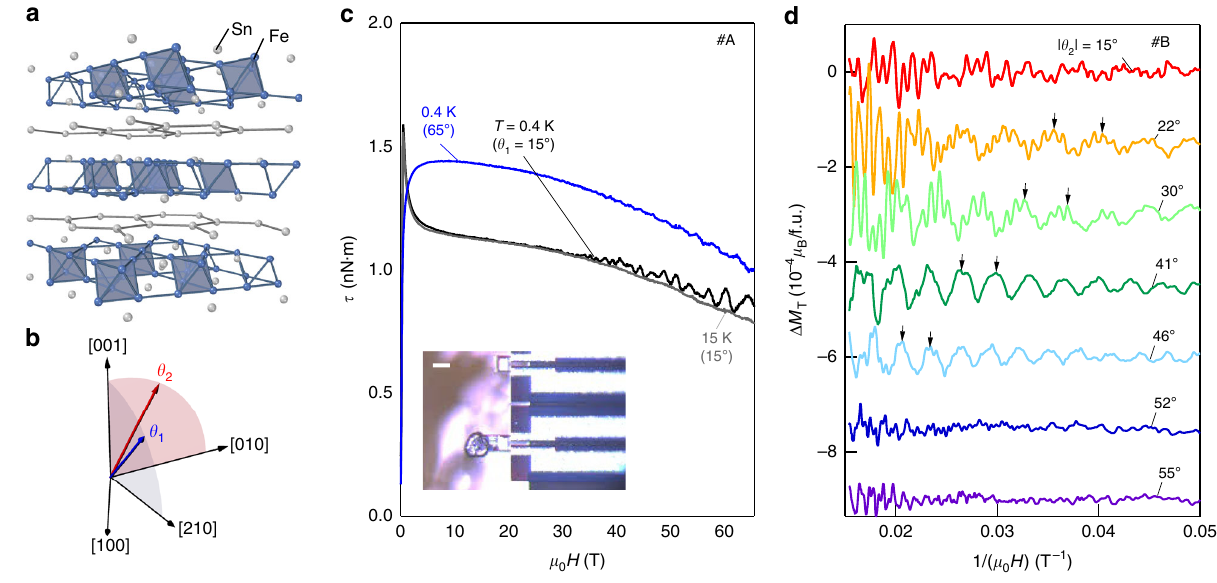
Fig. 1 Pulsed fi eld torque magnetometry and de Haas – van Alphen oscillations in Fe 3 Sn 2 . a Three-dimensional crystal structure of Fe 3 Sn 2 showing the Fe kagome bilayers partitioned by stanene honeycomb layers. The blue clusters are de fi ned by the shortest Fe – Fe bonds (<2.55 Å). b Depiction of rotation of the magnetic fi eld from out-of-plane to two inequivalent in-plane principal directions. The angles between the fi eld and c axis are de fi ned as θ 1 and θ 2 in the two rotation planes, respectively. c Magnetic torque τ measured up to 65 T for θ 1 = 15° and 65° with de Haas – van Alphen oscillations observed above ~20 T for T = 0.4 K. The inset shows an optical image of the piezoresistive cantilever with one crystal of hexagonal, plate-like Fe 3 Sn 2 (the scale bar is 50 μ m). d Oscillatory part of the transverse magnetization Δ M T at selected angles at base temperature T = 0.5 – 0.6 K versus inverse magnetic fi eld. The black arrows correspond to the eighth and ninth oscillation of the slow frequency at each